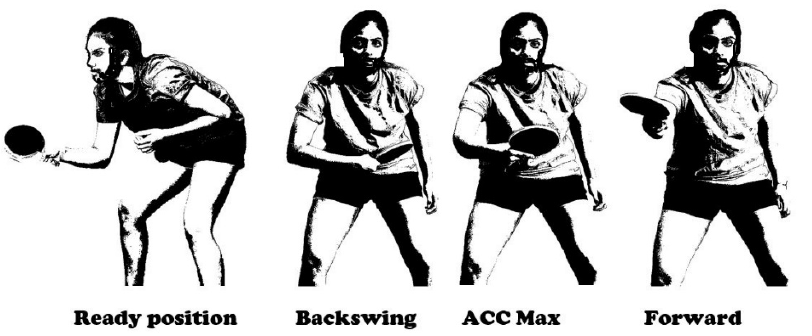
Figure 2. The indicated events of topspin backhand stroke.